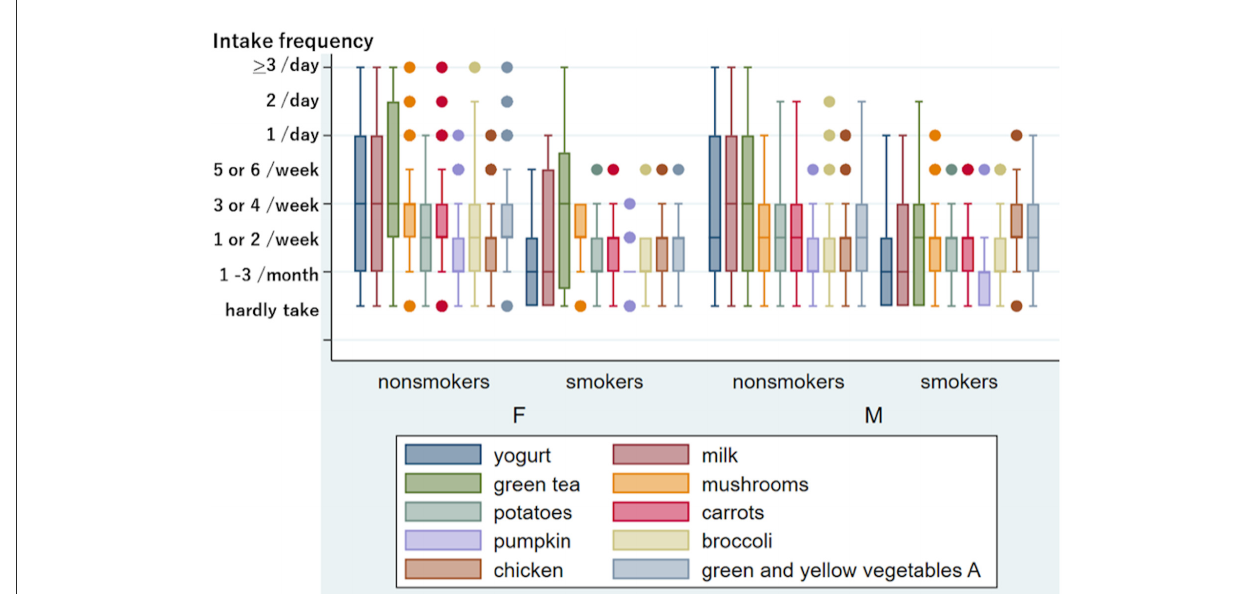
FIGURE1 Frequency of eating and drinking in non-smokers and current smoker among women and men. Ten kinds of food and drink with a significant difference between non-smokers and current smokers after adjusting for age in women and/or men. The y-axis shows the intake frequency divided into 8. If the median intake frequency is within the lower quartile, the box’s bottom line is thicker than its top line. Similarly, the box’s top line is thicker than its bottom line if the median intake frequency is within the upper quartile. Outliers indicated by dots include multiple individuals. The intake frequency and the number of persons indicated by words are as follows: in 269 female nonsmokers, mushrooms “hardly take”: five, “1/day”: 26, “2/day”: three, “ > 3/day”: one; carrots “hardly take”: seven, “1/day”: 13, “2/day”: one, “ > 3/day”: one; pumpkin “5 or 6/week”: five, “1/day”: one; broccoli “ > 3/day”: one; chicken “5 or 6/week”: eight, “1/day”: two; green and yellow vegetables A “hardly take”: two, “1/day”: 19, “2/day” five, “ > 3/day”: one. In 26 female smokers, mushrooms “hardly take”: two; potatoes “5 or 6/week”: one; carrots “5 or 6/week”: one; pumpkin “hardly take”: six, “1 or 2/week”: four, “3 or 4/week”: one; broccoli “5 or 6/week”: one; chicken “5 or 6/week”: one; green and yellow vegetables A “5 or 6/week”: one. In 166 male nonsmokers, pumpkin “5 or 6/week”: one; broccoli “5 or 6/week”: two, “1/day”: three, “2/day”: one; chicken “5 or 6/week”: three, “1/day”: three. In 49 male smokers, mushrooms “5 or 6/week”: three, “1/day”: one; potatoes “5 or 6/week”: one; carrots “5 or 6/week”: four; pumpkin “5 or 6 week”: one; broccoli “5 or 6/week”: four; chicken “hardly take”: one, “1/day”: one.